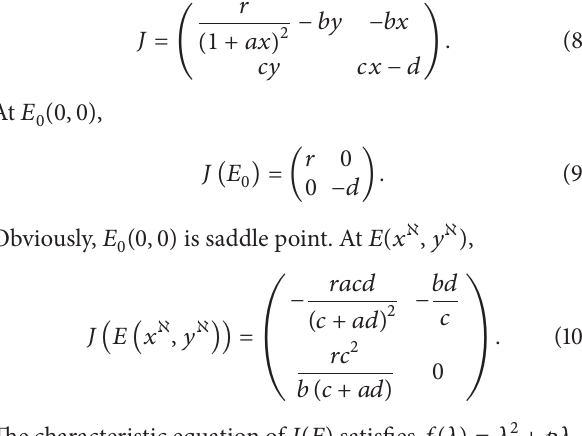
Then we have 𝑑Γ 3 /𝑑𝑡 < 0 for 0 < 𝑥 < 𝑑/𝑐 . According to